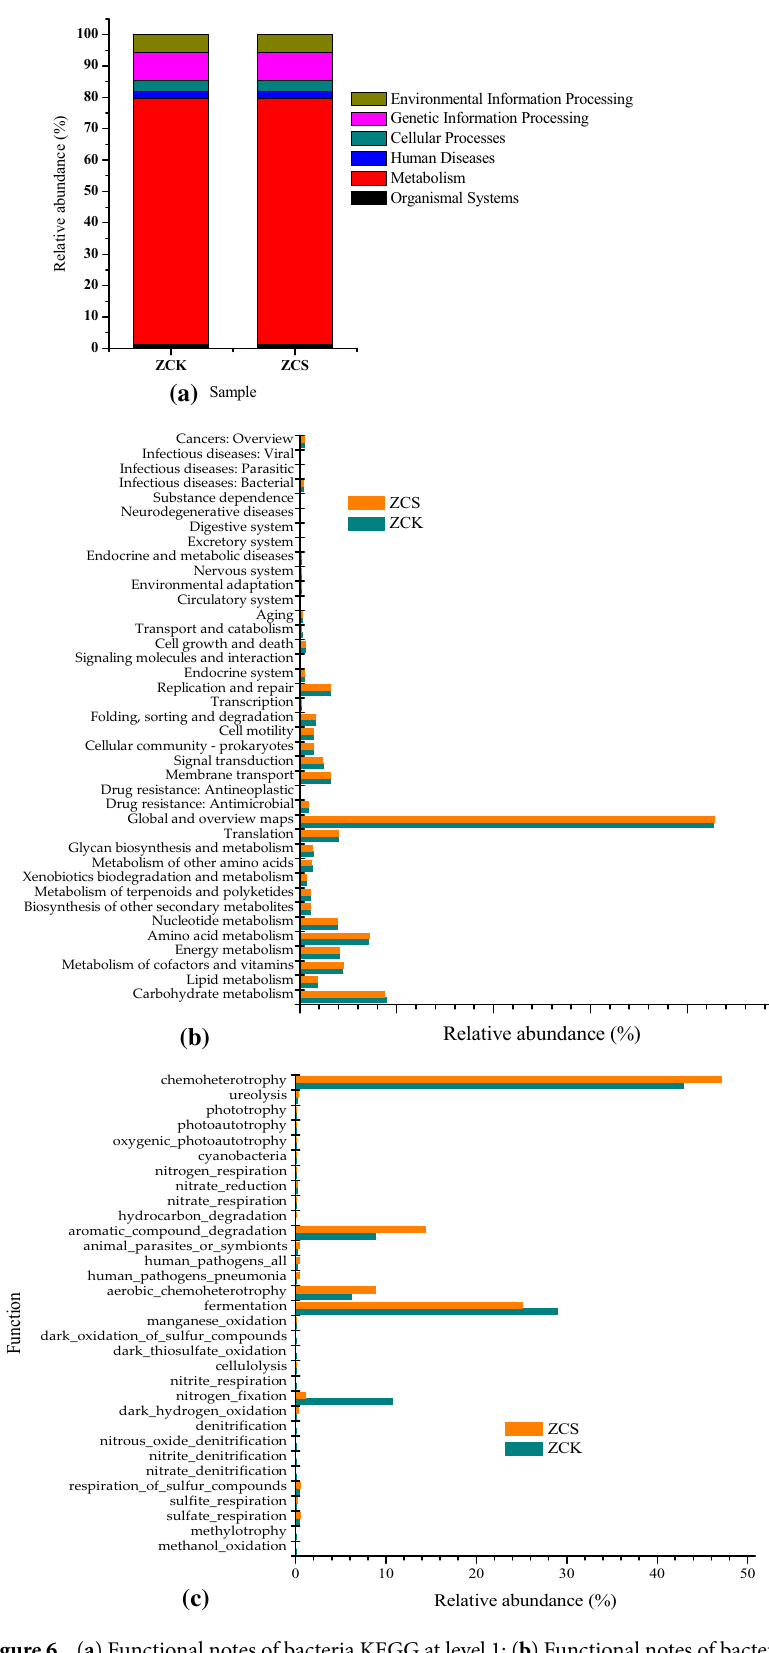
Figure 6. ( a ) Functional notes of bacteria KEGG at level 1; ( b ) Functional notes of bacteria KEGG at level 2; ( c ) Fapotax diagram of